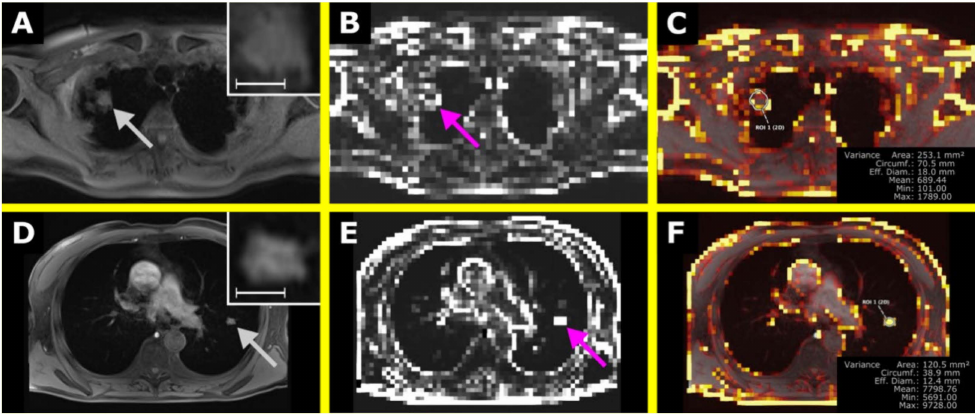
Figure 7. The upper row shows a pulmonary lymphoma manifestation in the right upper lobe with the T1-weighted (T1w) image in ( A ) and the corresponding map of Variance in ( B ). In ( C ), an overlay was created, also showing a ROI to retrieve Variance within the lesion. The lower row shows a non-lymphoma infiltrate in suspected fungal pneumonia in the left upper lobe with the T1w image in ( D ), the corresponding map of Variance in ( C ), and the overlay in ( F ). In ( A , D ), the lesions are shown in a magnified section in the upper right corner. The scale indicates 1 cm. ( E ) is the corresponding map of Variance of ( D ). The VISAGE Viewer was used to create the overlay map and to perform the measurements (Visage Imaging Client 7.1.15; Visage Imaging GmbH, Berlin,